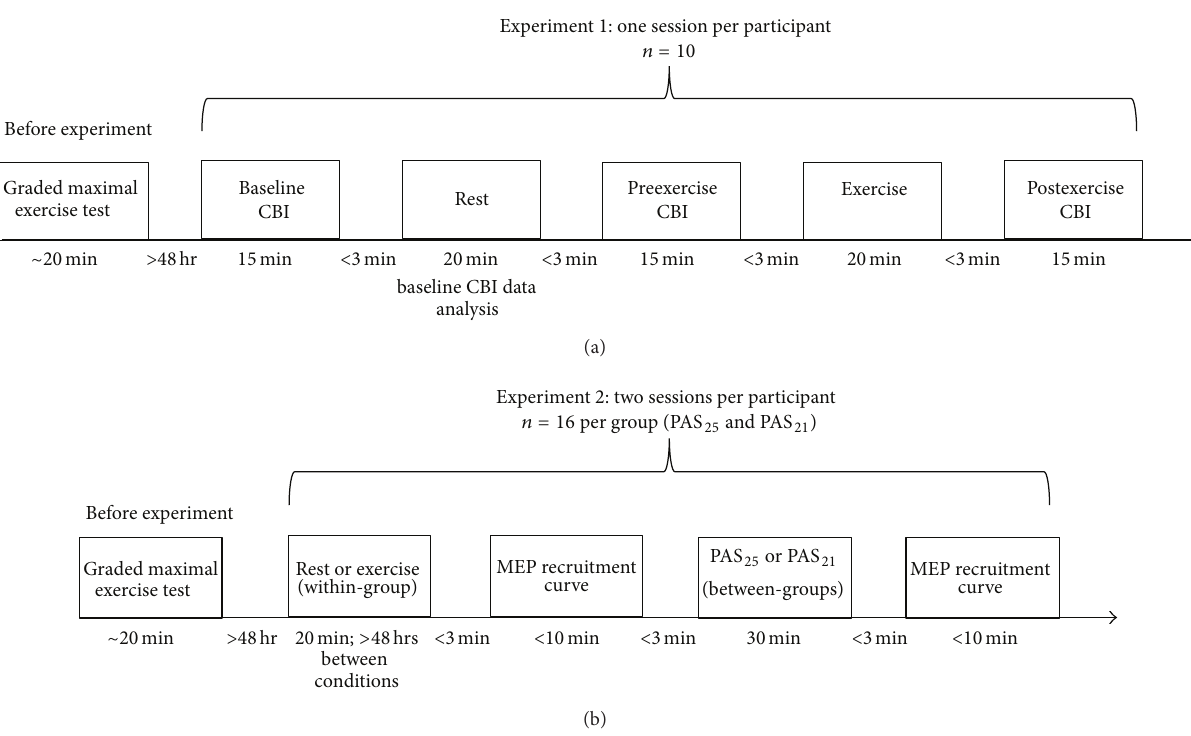
Figure 1: Overview of experimental procedures for Experiment 1 (a) and Experiment 2 (b). Each session was approximately two hours in duration. CBI: cerebellar inhibition; MEP: motor evoked potential; PAS 25 : paired associative stimulation with 25 ms interstimulus interval; PAS 21 : paired associative stimulation with 21ms interstimulus interval.